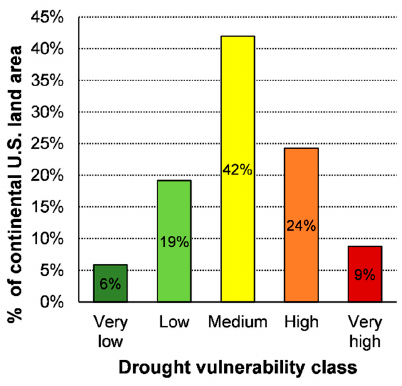
Figure 8. Areal portion of the contiguous U.S. found in each vulnerability